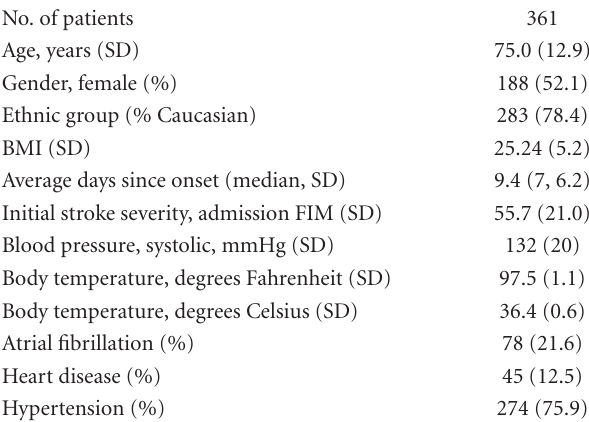
Table 1: Basic characteristics of the patients.